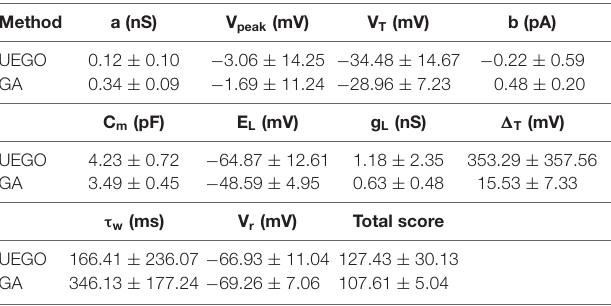
TABLE 3 | Comparative table of best solutions from UEGO and regular